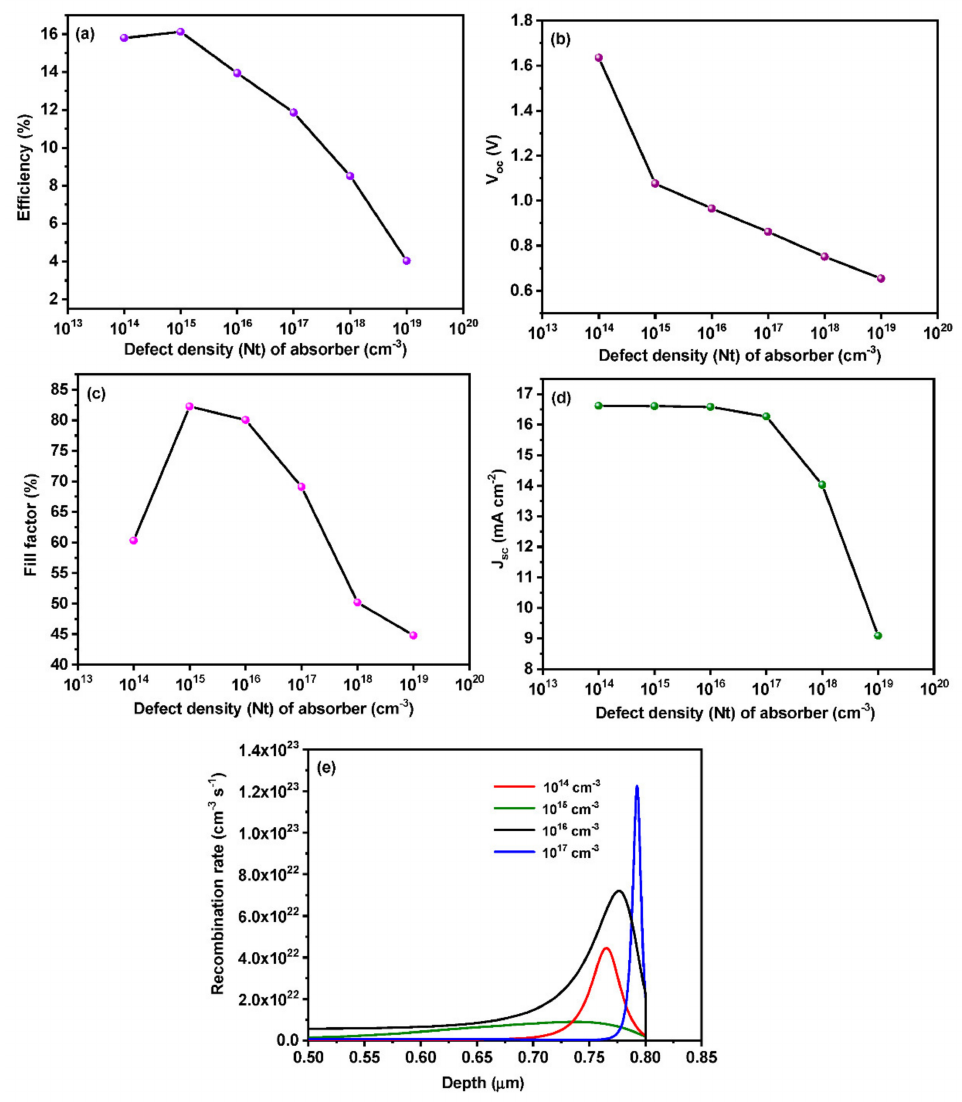
Figure 7. Effect of absorber layer defect density on ( a ) efficiency, ( b ) V oc , ( c ) fill factor and ( d ) J sc ( e ) recombination rate inside